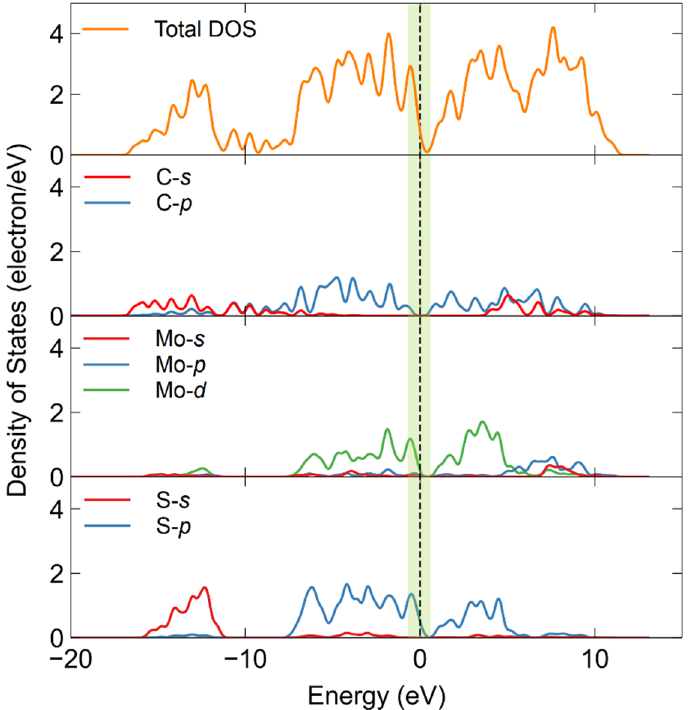
Figure 3. Total and partial of states of simulated graphene-MoS 2 .